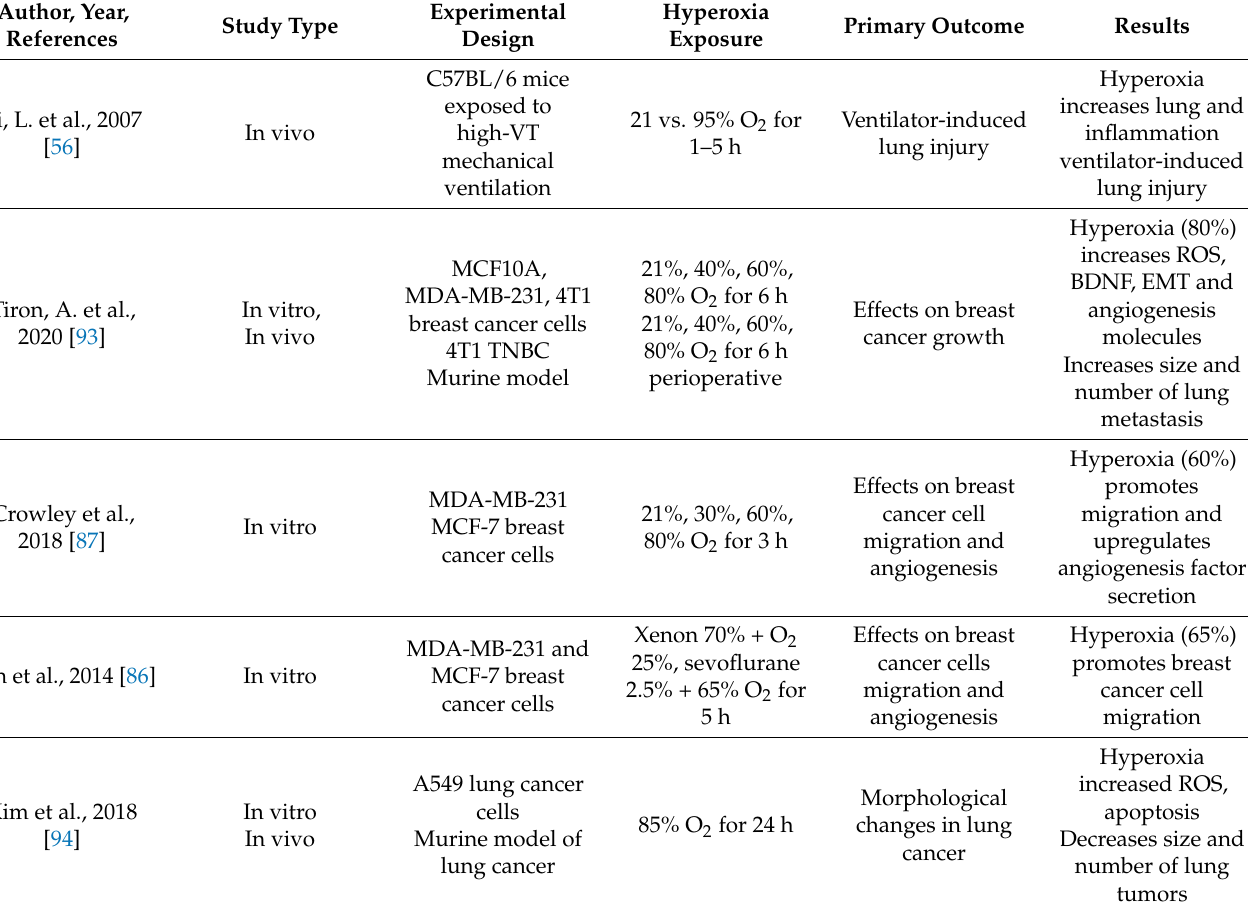
Table 2. Experimental in vitro and in vivo studies exploring hyperoxia exposure effects in